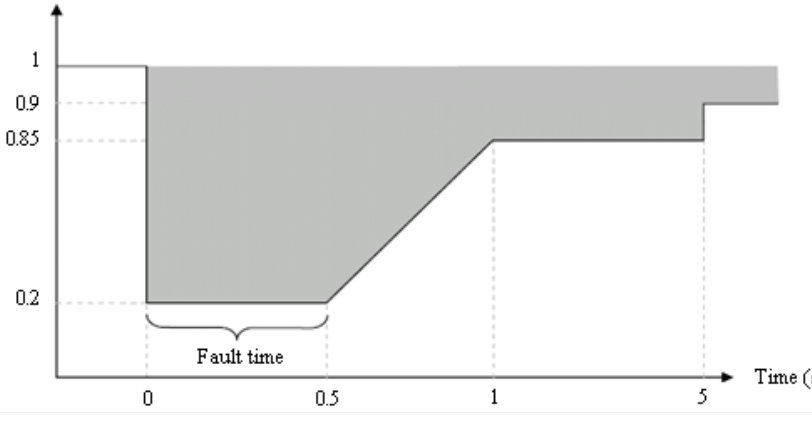
Figure 2. Voltage at wind generator terminals (Source: ONS).